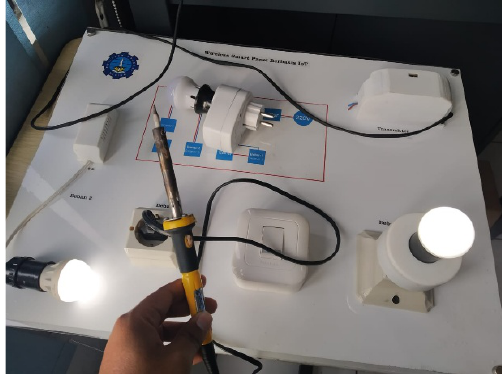
Figure 8. The circuit before overloading